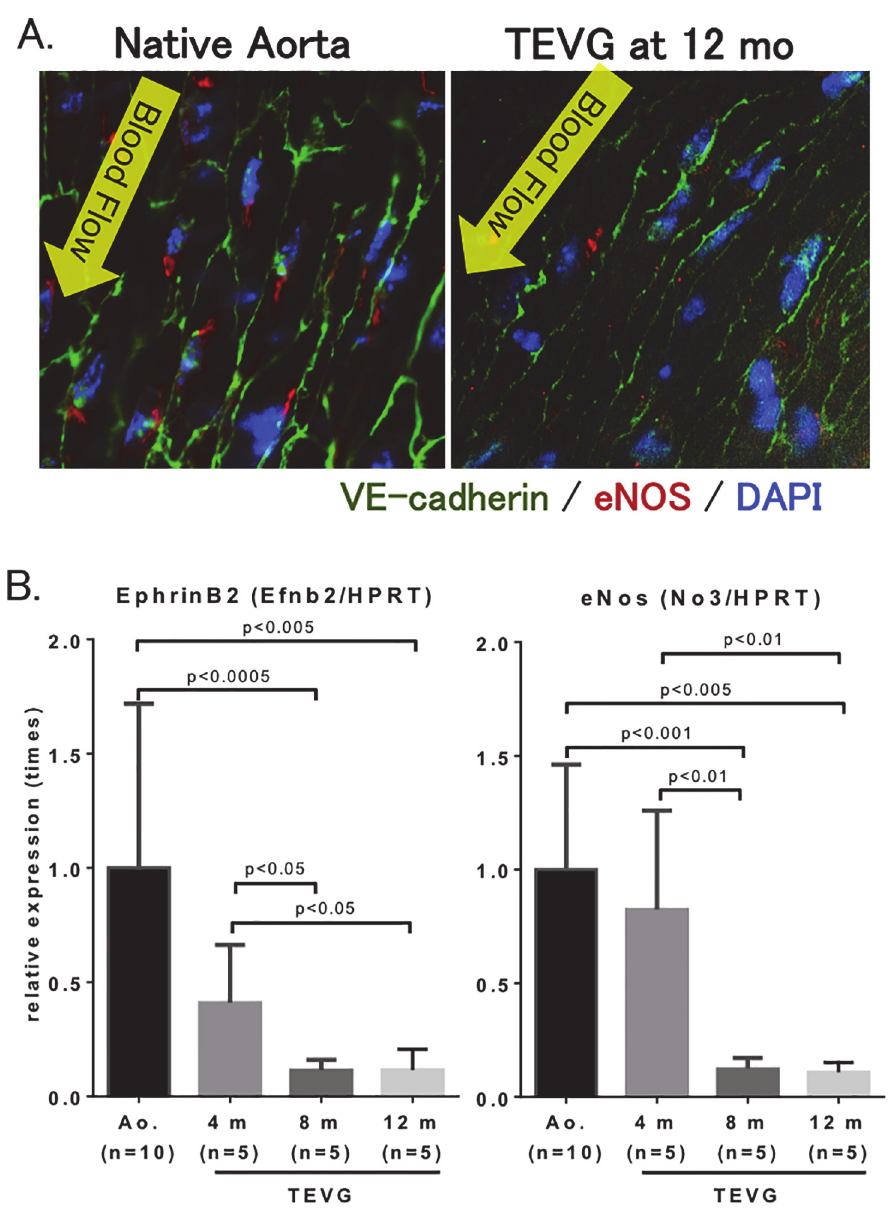
Fig 7. Expression of endothelial markers indicate functional endothelium in TEVG. A. Whole mount staining of native aorta and TEVG. VE-cadherin is a marker of cellular borders of endothelial cells (green). Endothelial nitric oxide synthase (eNOS) is a marker of a functional endothelium (red). DAPI is a nuclear stain (blue). B. Real-time PCR analysis of ephrinB2 and eNOS. Ephrin-B2, a marker of arterial vessels. (n = 5 – 10 in each